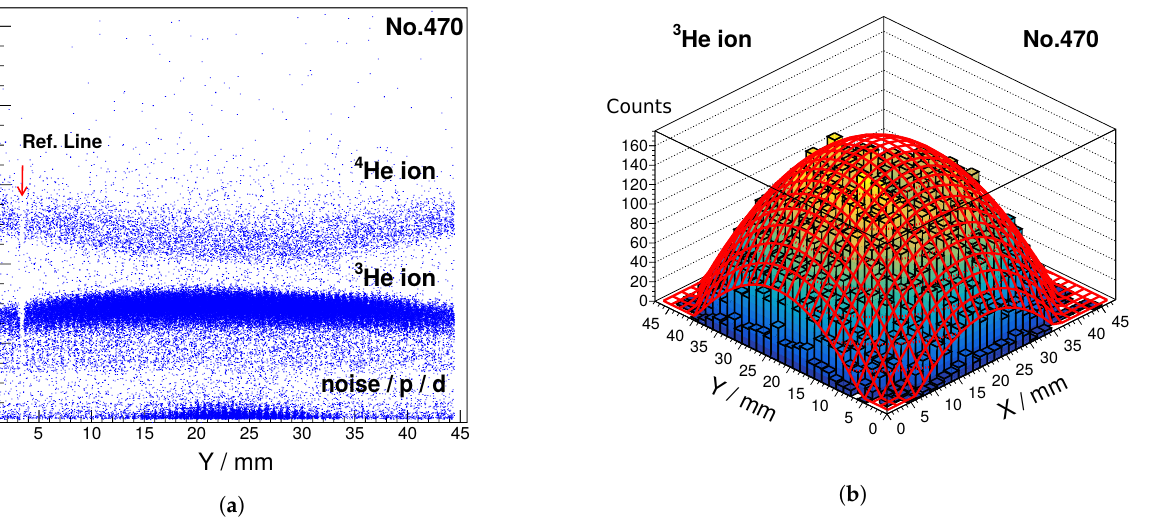
Figure 12. Beam monitor at the Forward position of the polarimeter. ( a ) Particle identification on the CR-39 plate, showing the separation of 4 He ions, 3 He ions and background. ( b ) 2D distribution of beam particles, fitted with a 2D quadratic function in vertex form to find the center position of beam-foil